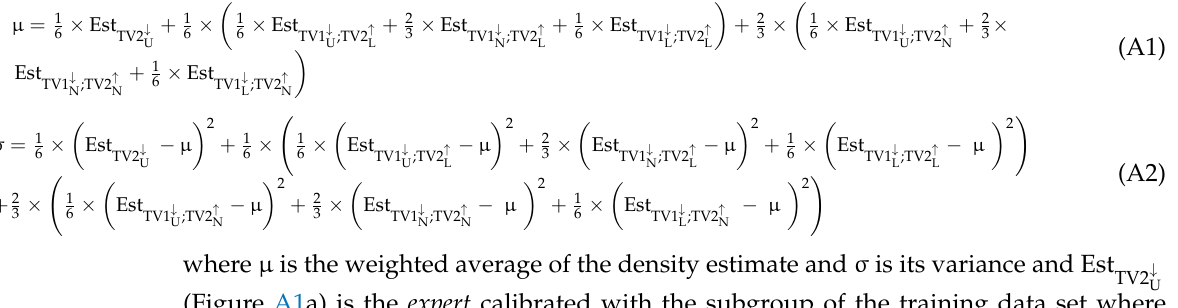
(Figure A1b), Est (Figure A1c) and Est TV1 ↓ N ;TV2 ↑ L